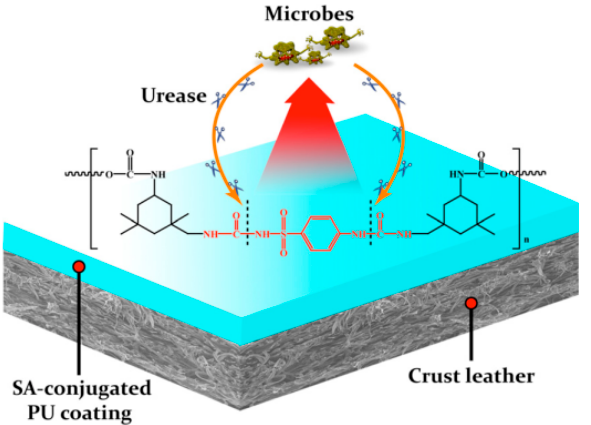
Figure 14. Schematic illustration of possible mechanism by which the SA-conjugated PU leather coating functions [90].